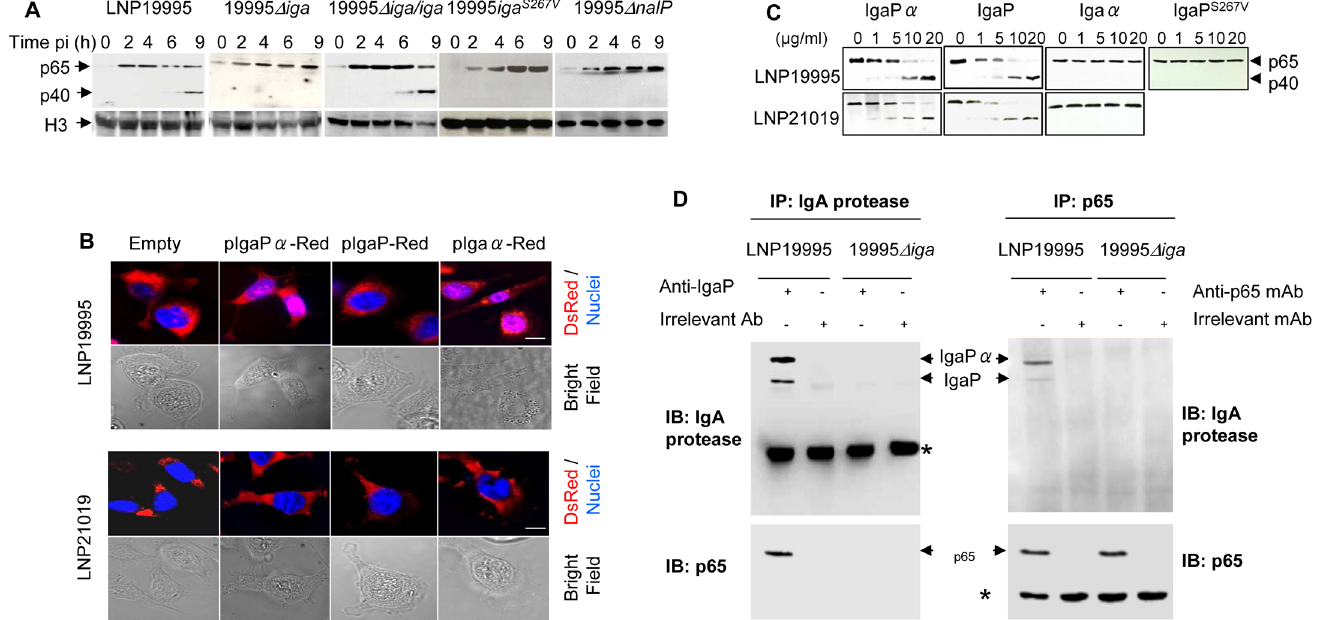
Fig 4. IgA protease of ST-11 isolates interacts with and mediates nuclear cleavage of p65/RelA. (A) Hec-1-B cells were infected with the indicated strains. For each time point, nuclear fractions were prepared and analysed by immunoblotting using anti-p65 mAb. Histone H3 was used as loading control. (B) Localization of IgA protease sub-domains in transfected infected cells. IgaP, Iga α or IgaP α of LNP19995 (upper panel) or LNP21019 (lower panel) were fused to DsRed. Hec-1-B cells were then transfected with either construct or pDsRedN1 plasmid (Empty vector). After 48 hours, cells were washed, fixed with 3.7% PFA and stained with DAPI (blue) before visualisation under the microscope. Scale bar (10 μ m) is shown. (C) In vitro activity of purified IgA protease passenger sub-domains against p65. IgaP, Iga α or IgaP α or IgaP S267V of the strains LNP19995 (upper panel) and LNP21019 (lower panel) were subcloned and purified as C-terminal His 6 -tagged proteins. Nuclear extracts (1 μ g) from LPS-stimulated Hec-1-B cells were mixed with the indicated concentrations of the purified proteins. The reaction mixtures were incubated at 25°C for 3 hours and then analyzed with antibodies against p65/RelA (N-terminal specific). (D) IgA protease interacts with p65/RelA. Nuclear extracts from LPS-stimulated Hec-1-B cells were mixed with MSP prepared from LNP19995 or 19995 Δ iga for 6h in presence of 5 mM PMSF. The samples were immunoprecipitated with anti-IgaP specific serum or irrelevant rabbit Ab (left panel) or anti-p65/RelA mAb or irrelevant mAb (right panel) and analyzed by immunoblotting with antibodies against p65/RelA and IgaP, respectively. * indicates antibody heavy